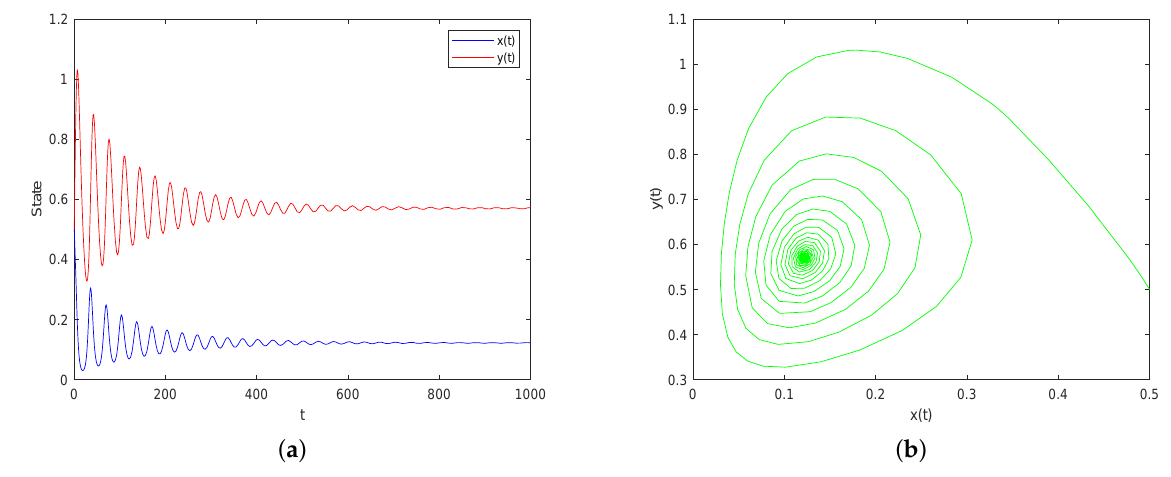
Figure 8. ( a ) Time series and ( b ) phase portrait of E ∗ for system (1) when τ 1 = 3.5 and τ 2 = 0.2. Other parameters are the same as in (32).